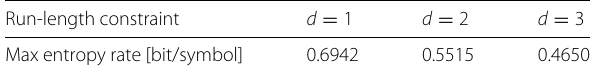
Table 2 Maximum entropy of d -constrained sources Run-length